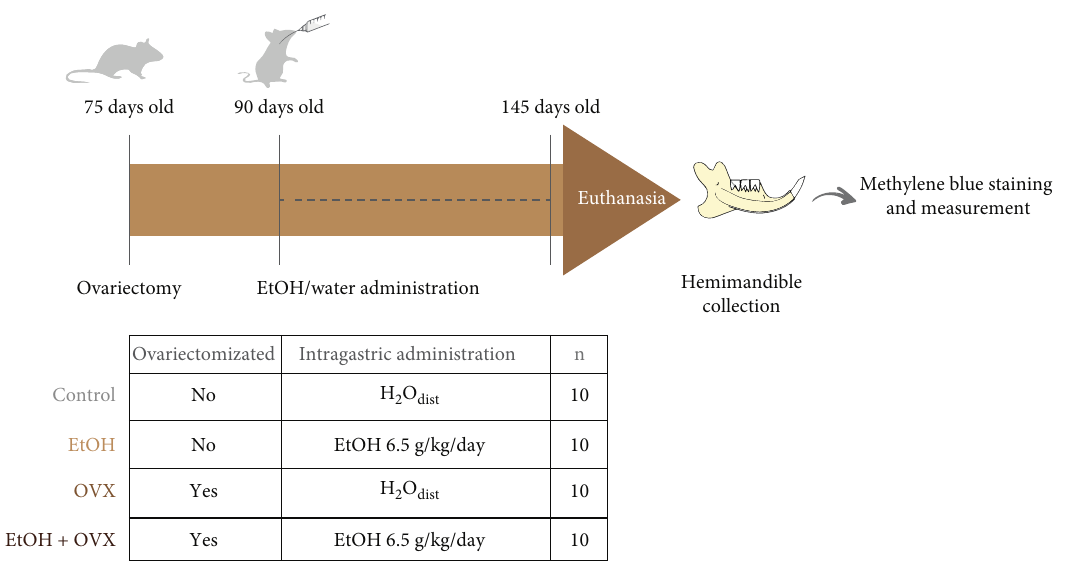
Figure 1: Study design. First, the female Wistar rats were ovariectomized at 75 days of age. After 15 days of the procedure, distilled water–H 2 O dist (Control group; OVX group) or ethanol–EtOH (EtOH group; EtOH+ OVX) were administered by intragastric gavage during 55 days. At the end of the administration, the animals (145 days old) were euthanized. Their hemimandibles were collected. Afterwards, they were stained with methylene blue allowing the measurement of alveolar bone loss with stereomicroscope.